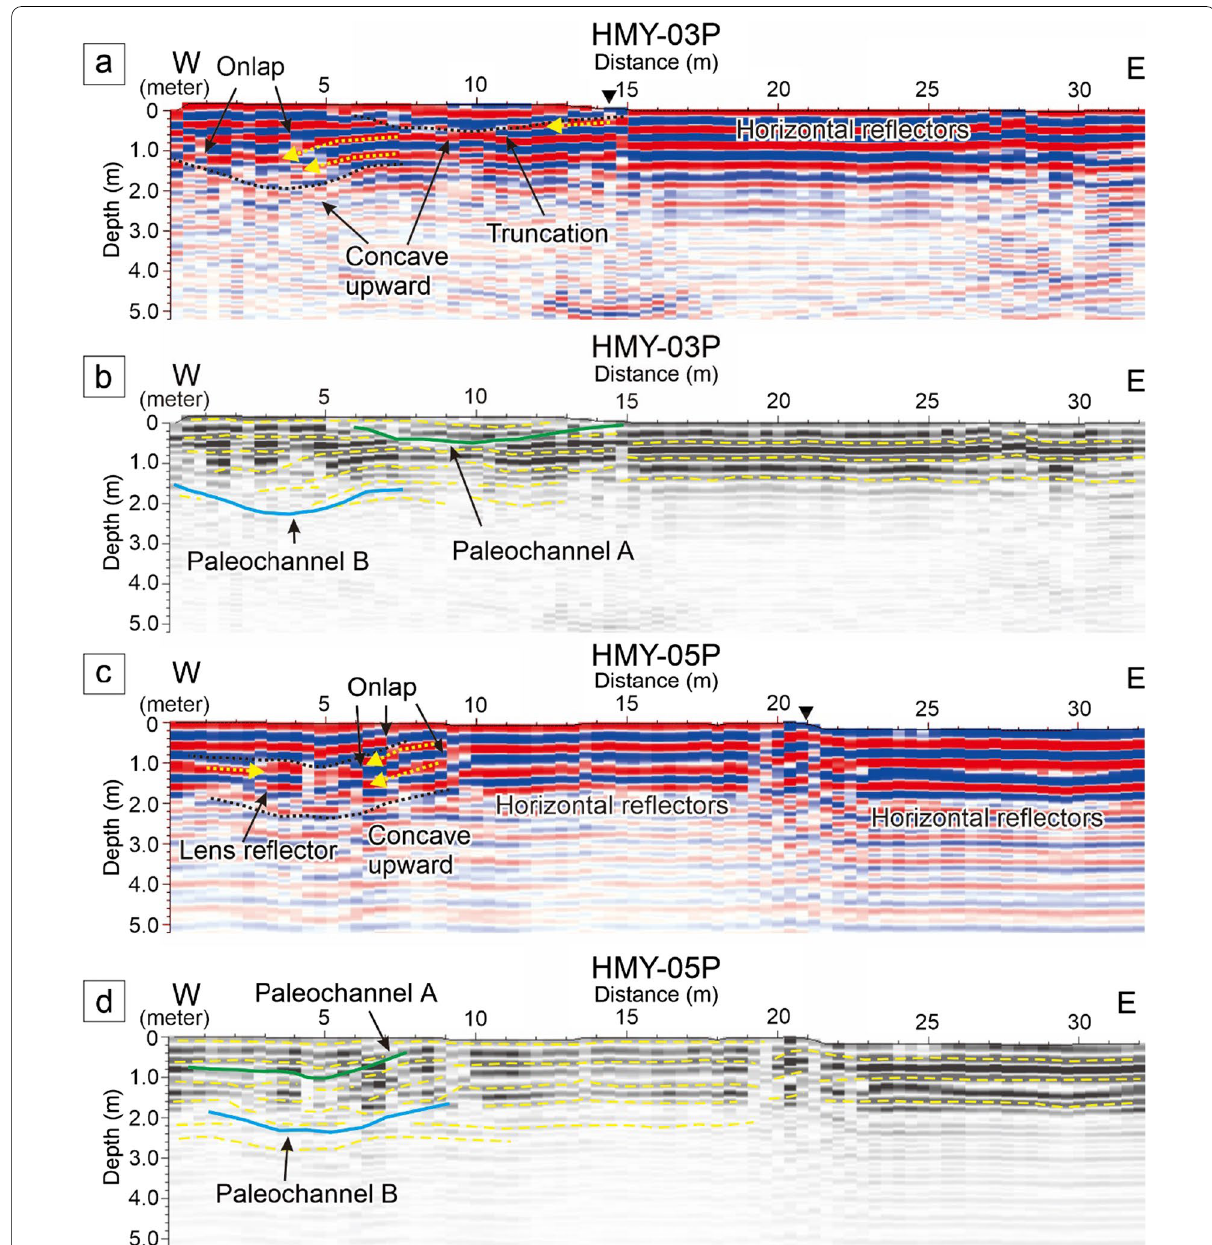
Fig. 7 a Processed GPR section of the HMY-03P. b Interpretation of the HMY-03P. c Processed GPR section of the HMY-05P. d Interpretation of the HMY-05P. The dashed yellow line indicates the trace of reflectors. The yellow dotted arrow indicates the dip of reflectors. Black triangles mark the concrete structures at the